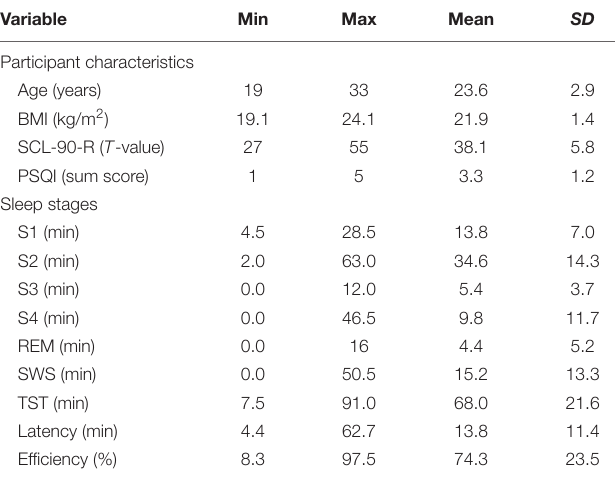
TABLE 1 | Descriptives of questionnaire and sleep